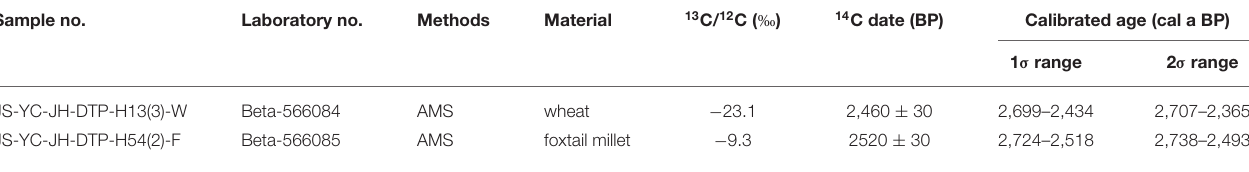
TABLE 1 | 14 C dates from the Datongpu